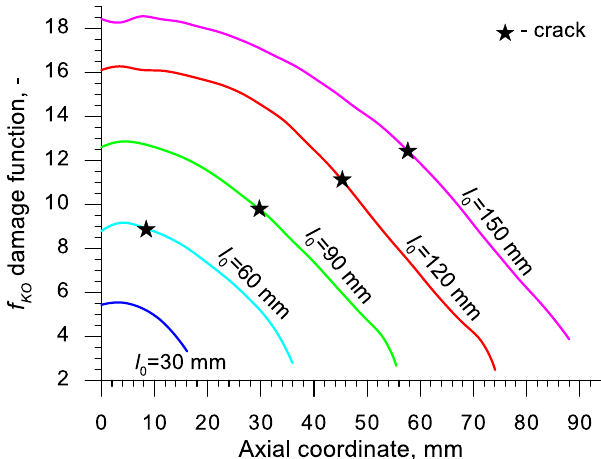
Figure 25. Distributions of the damage function in the axis of a rotationally compressed sample, determined on the basis of the Ayada criterion.